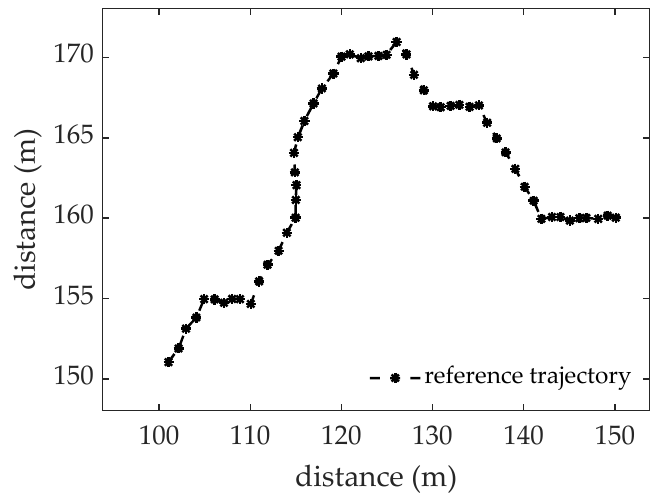
Figure 4. The reference trajectory.